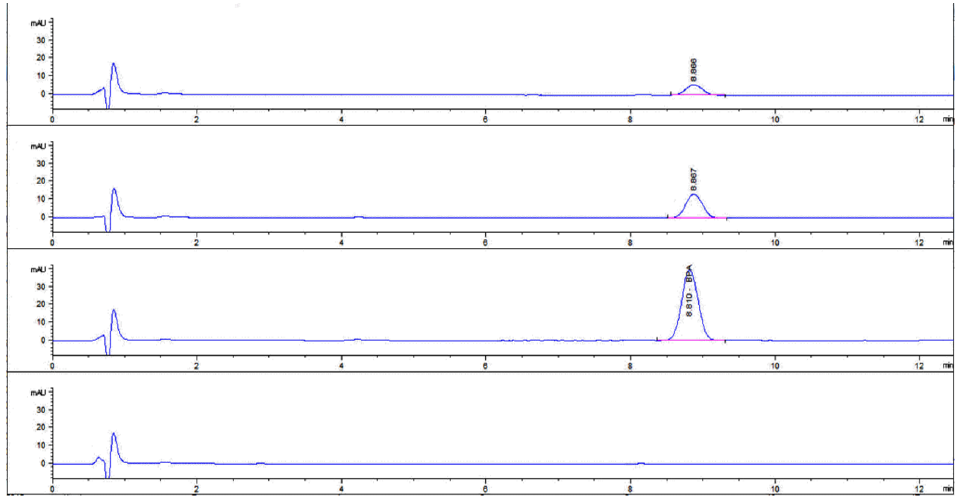
Figure 6. HPLC Chromatogram representing, from the bottom to the top, the samples P4-1, P3-1, P2-1 and P1-1.